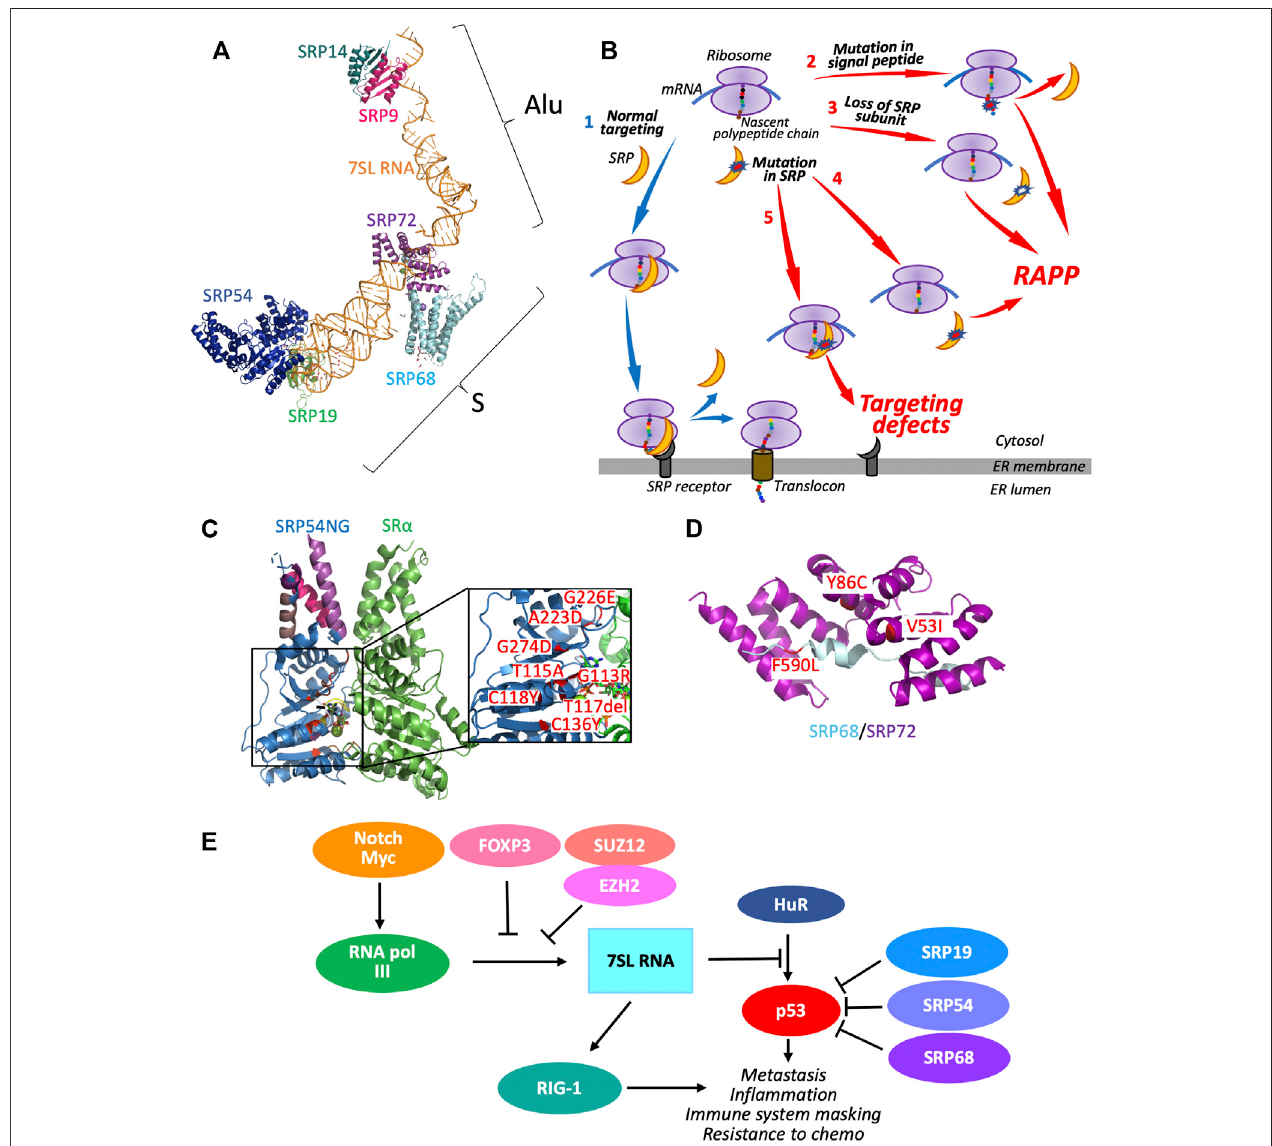
FIGURE 1 | Signal Recognition Particle (SRP) and human diseases. (A) SRP molecular model. The picture was prepared using PyMol software (Schroedinger 2020).TheSRPprotein subunits areassembled on7SL RNA(orange,from PDB 1RY1(Halicet al.,2004)), and composed ofAlu domain proteins SRP9(magenta, from PDB1RY1(Halicetal.,2004))andSRP14(teal,fromPDB1RY1(Halicetal.,2004));andS-domainproteins:SRP72(purple,fromPDB5WRW(Gaoetal.,2017)),SRP68 (light blue, from PDB 5WRV and 4P3F (Grotwinkel et al., 2014; Gao et al., 2017)), SRP19 (green, from PDB 1RY1 (Halic et al., 2004)), and SRP54 (dark blue, from PDB 1MFQ and 1RY1 (Kuglstatter et al., 2002; Halic et al., 2004)). (B) SRP cycle and possible dysregulation. Scenario 1 – During normal biogenesis, secretory proteins are recognized by SRP (orange crescent) during their synthesis on ribosome (violet ovals). SRP binds N-terminal signal sequence of the nascent polypeptide chain of secretory protein (chain of colored circles), pauses the translation and targets ribosome-nascent chain complex to SRP receptor (dark grey) in ER membrane. Interactions between SRP and SRP receptor lead to transfer of paused ribosomes to the translocon (brown cylinder) followed by release of SRP and continuation of protein synthesis. The nascent chain is translocated through the ER membrane into the lumen for further transport and modi fi cations. Scenarios 2 – 5 are schematic presentations of events occurring when SRP pathway is defective. Scenario 2 – A mutation in the hydrophobic part of the N-terminal signal sequence leads to loss of interactions with SRP and induction of Regulation of Aberrant Protein Production (RAPP) and secretory protein mRNA degradation. Scenario 3 – Lack of SRP subunit inducesRAPP.PathologyofantibodiesagainstSRPmayalsoleadtointerferencewithfunctionalSRPcomplexassemblypotentiallyresultinginRAPP.MutationsinSRP subunits may lead to two possible scenarios – if they interfere with SRP binding to nascent chain, they may potentially induce RAPP (Scenario 4); if mutations in SRP subunits do not affect SRP recognition but interfere with SRP binding to SRP receptor, they may impact protein targeting (Scenario 5). Possible dysregulation events, described here, may cause the defects in expression or transport of secretory and membrane proteins in mammalian cells. (C) Clinical SRP54 mutations. Mutations in SRP54NG domain (marked in red) shown in proximity tothe SRPreceptor SR α subunit. (D) Clinical SRP68 and SRP72 mutations. Mutations are marked in red,binding domains of SRP68 and SRP72 are in light blue and purple, respectively. Illustrations in C and D were made by using PyMol software, PDB for SR α is 5L3Q (Wild et al., 2016), coordinates for SRP proteins and references are presented in (A) . References for the mutations are presented in the main text. (E) SRP proteins and 7SL RNA